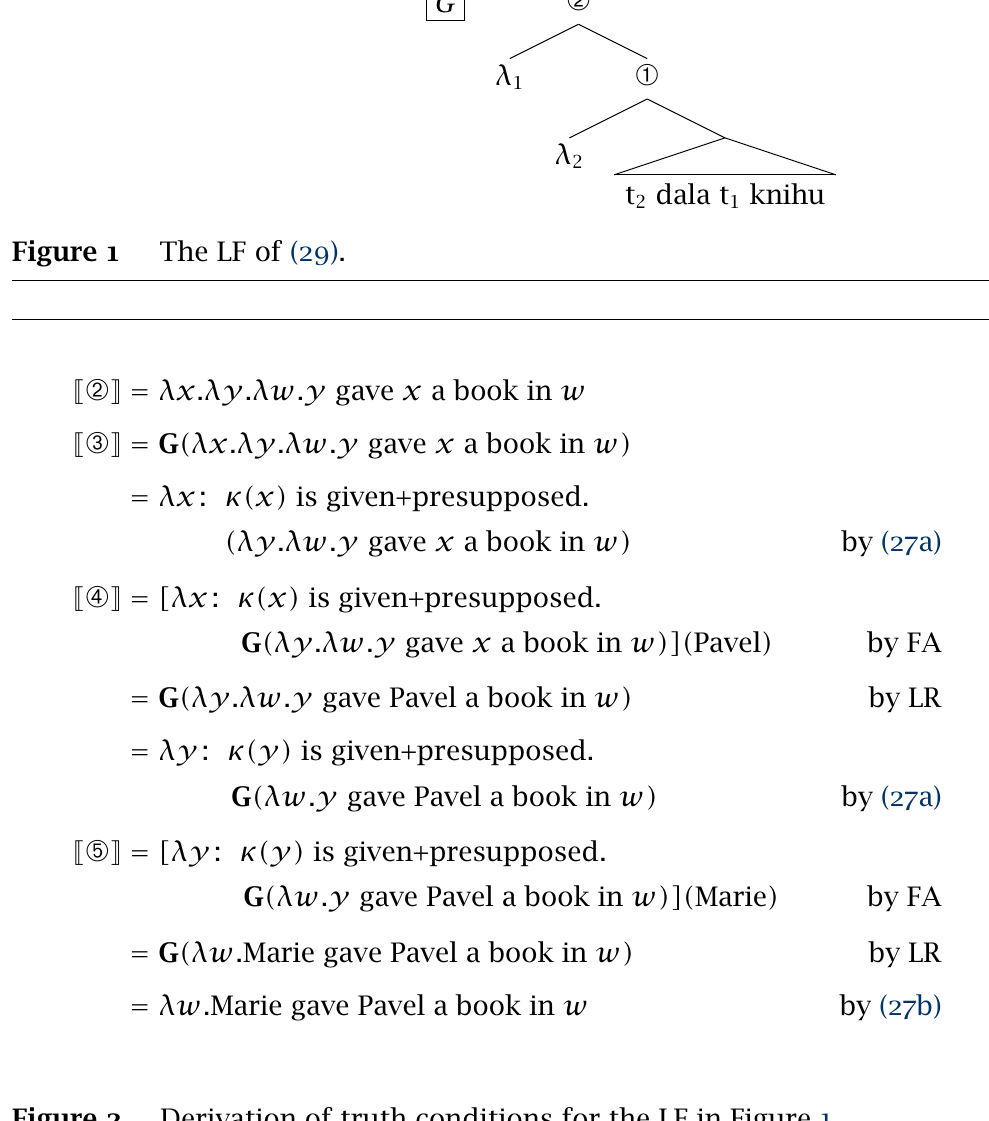
Figure 2 Derivation of truth conditions for the LF in Figure 1